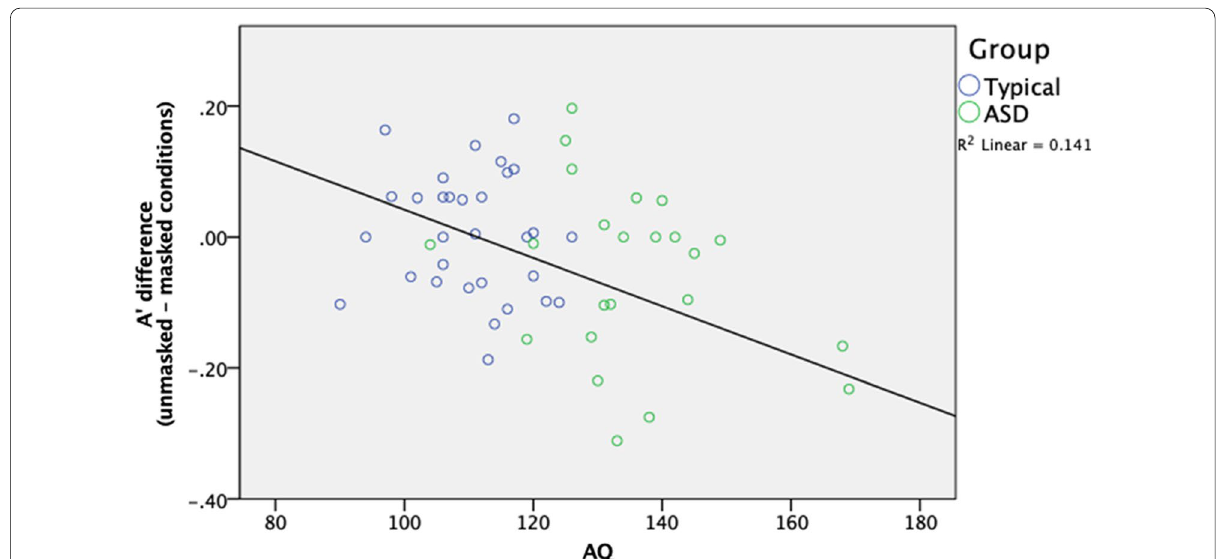
Fig. 5 Correlations between difference in A’ between the unmasked and masked conditions